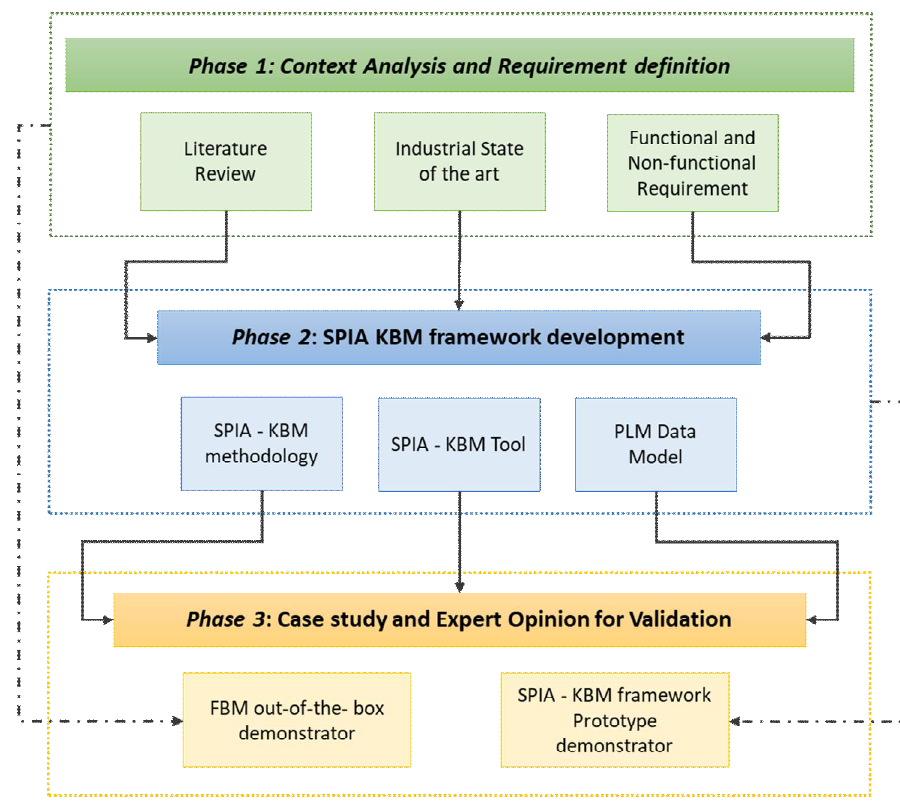
Figure 1. Research methodology.